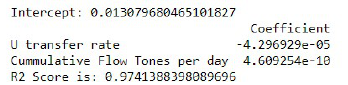
Figure 9. R2 Score for shell and tube heat exchanger